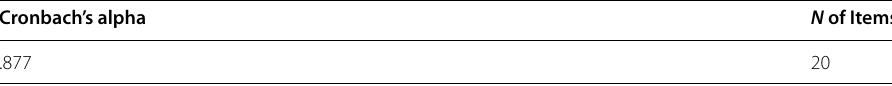
Table 3 Reliability statistics of the Social Class Questionnaire Cronbach’s alpha N of Items